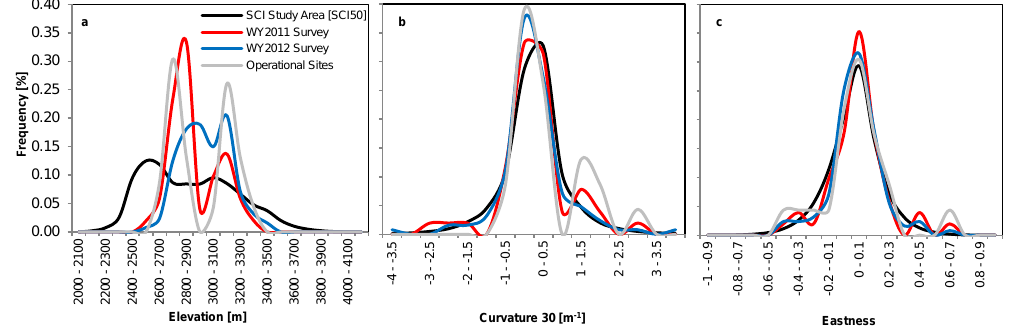
Fig. 5. Histograms of terrain variables across the SCI 50 study area compared to variables associated with snow measurement locations.